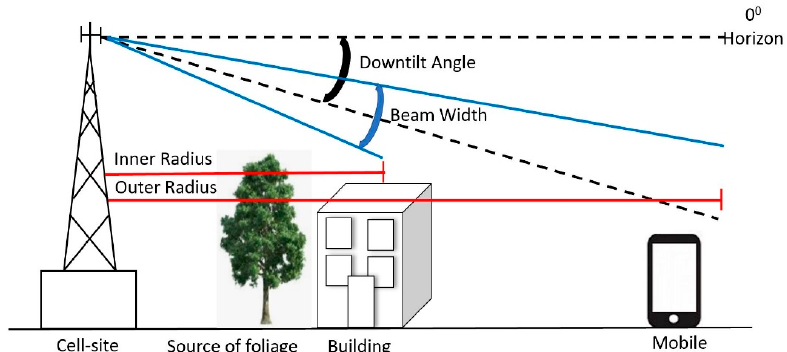
Figure 22. RF coverage with antenna downtilt.